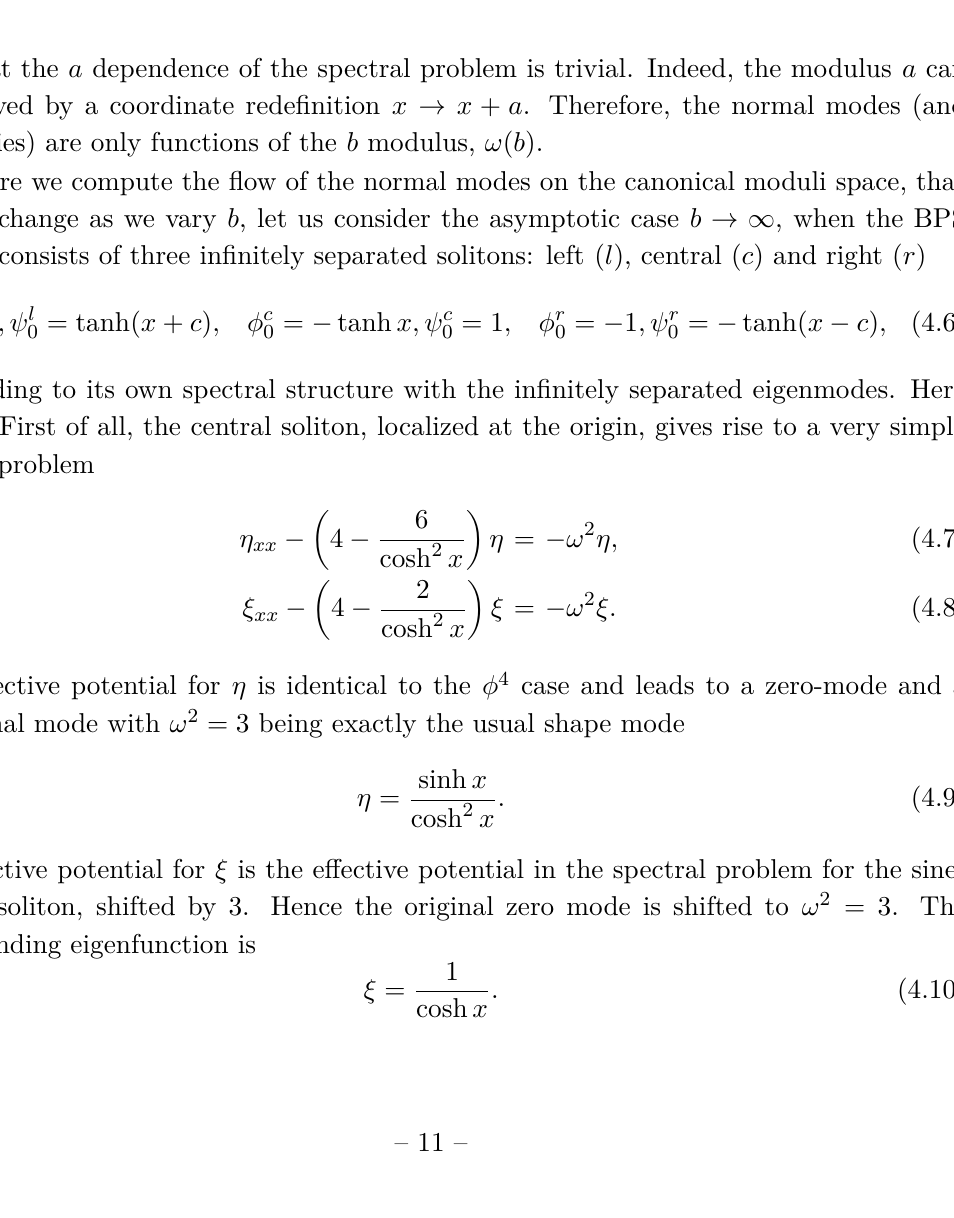
= 1 , ψ l = tanh x 0 0